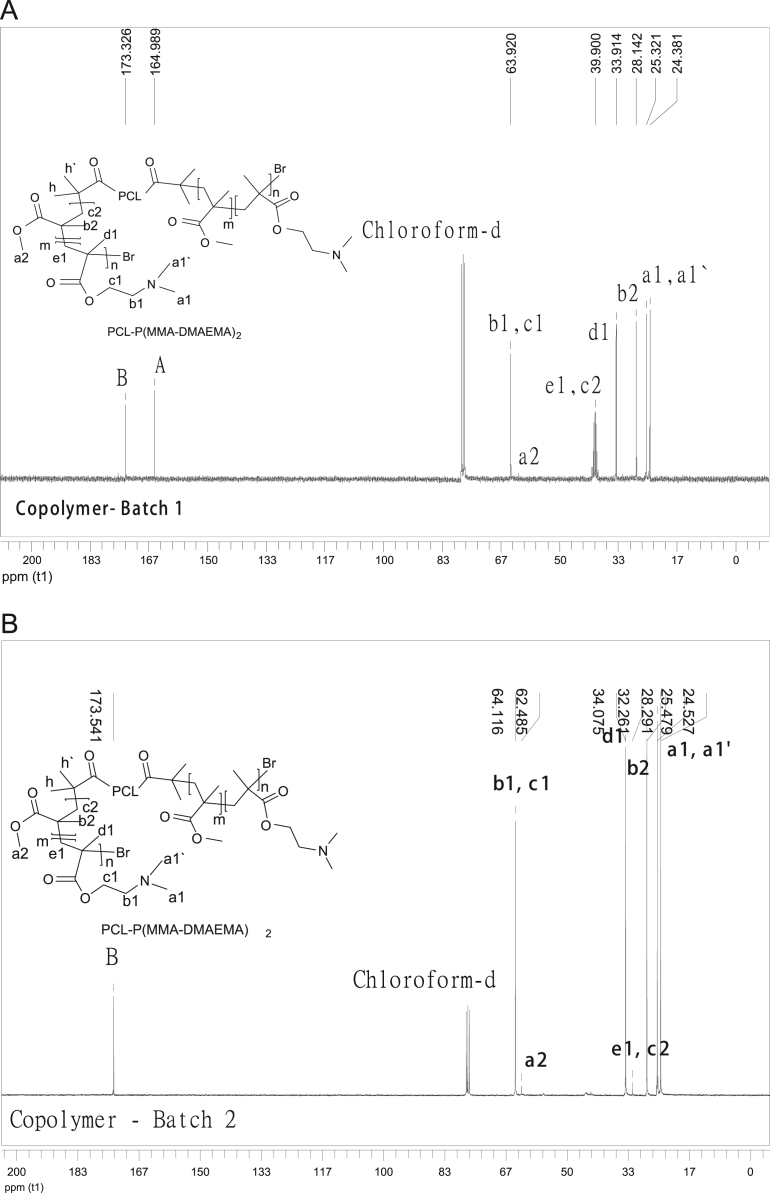
13C NMR (CDCl3, 300 MHz) spectra of PCL-b-P(DMAEMA-co-MMA)2 batch 1 (A) and batch 2 (B).